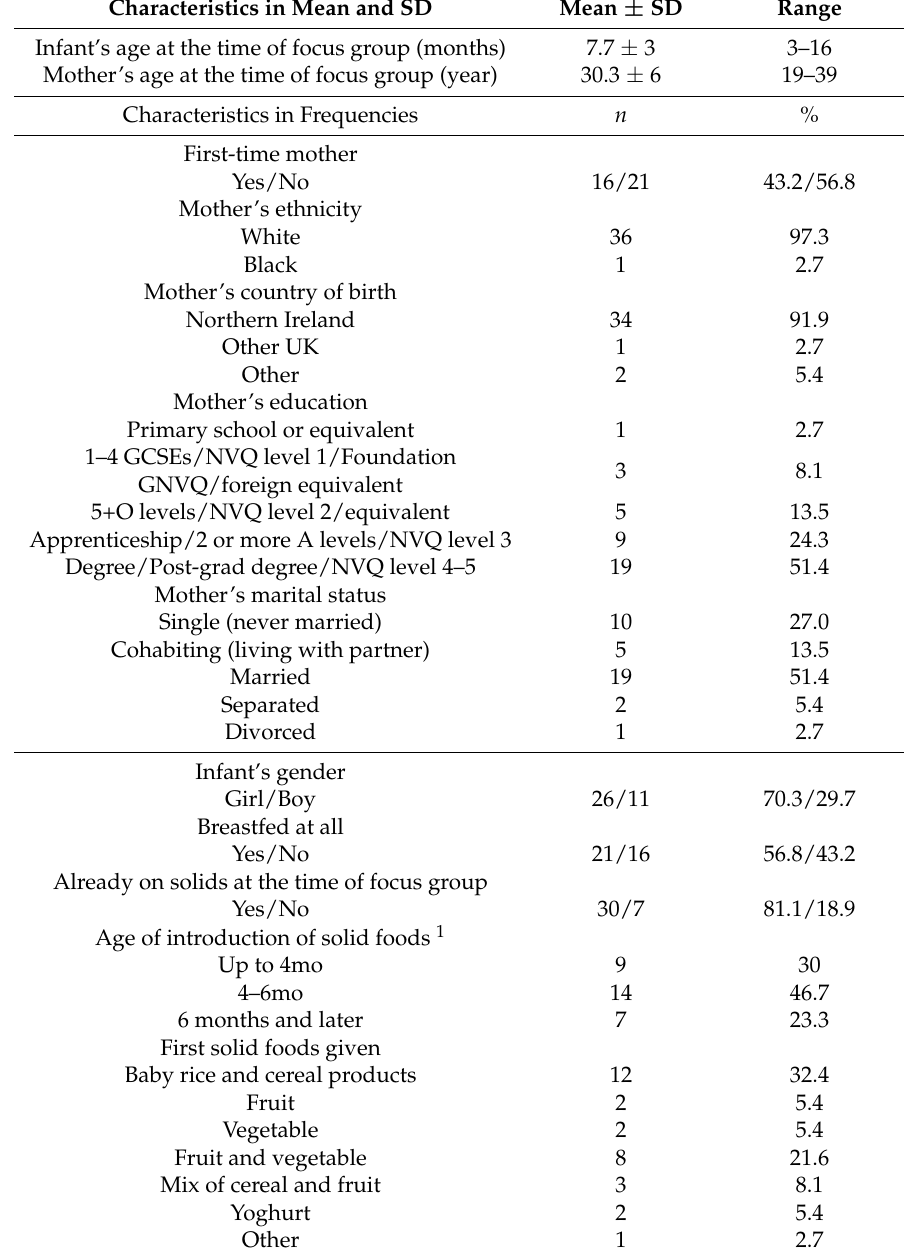
Table 2. Mothers’ and infants’ characteristics, n =